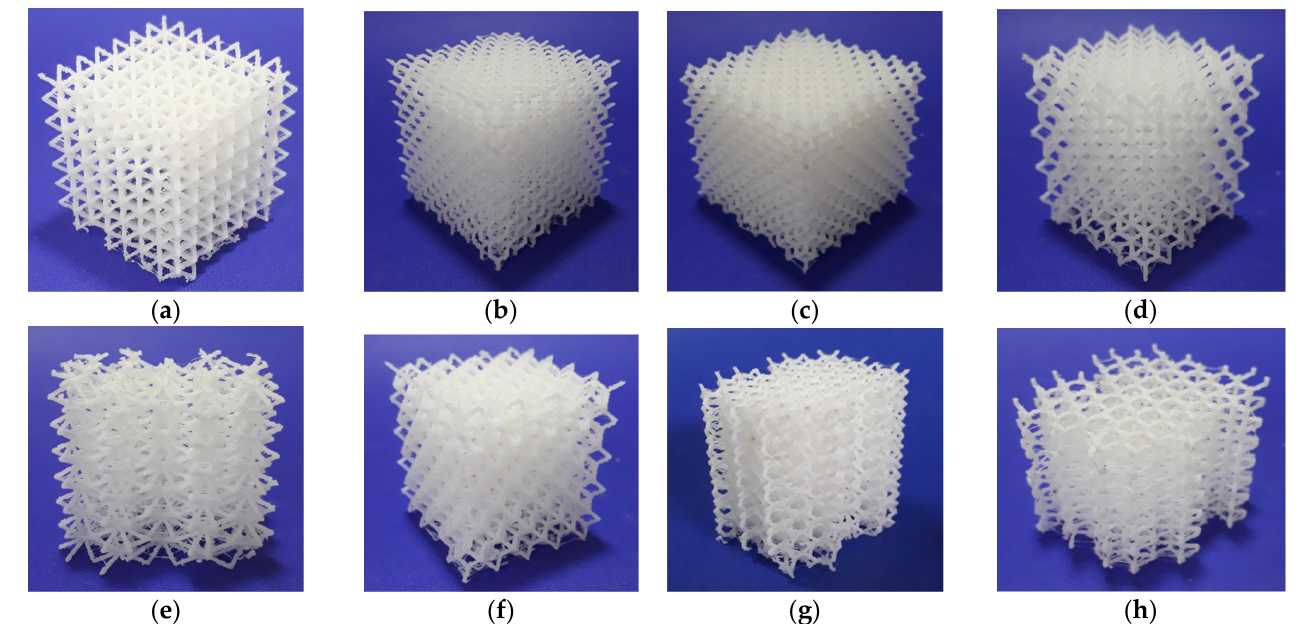
Figure 3. 3D printed lattice structures (scale 1:1, Up mini 2, ABS): ( a ) cube vertex centroid; ( b ) cubic diamond; ( c ) cubic fluorid; ( d ) tet vertex centroid; ( e ) hex prism vertex; ( f ) tet oct vertex centroid; ( g ) hex prism diamond; ( h ) hex prism laves phase. Dimensions of specimens are reported in Table 4.